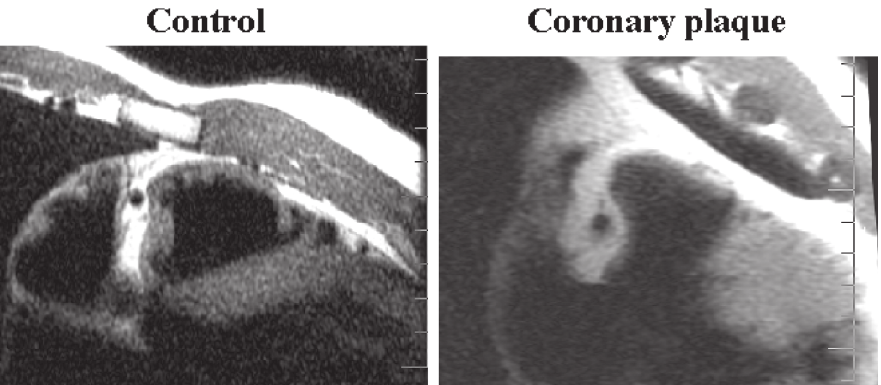
Figure 2 - Magnetic resonance of coronary arteries. Observe the increment of wall thickness and total vessel diameter of diseased vessel, a positive remodeling (right) compared to the control (left)